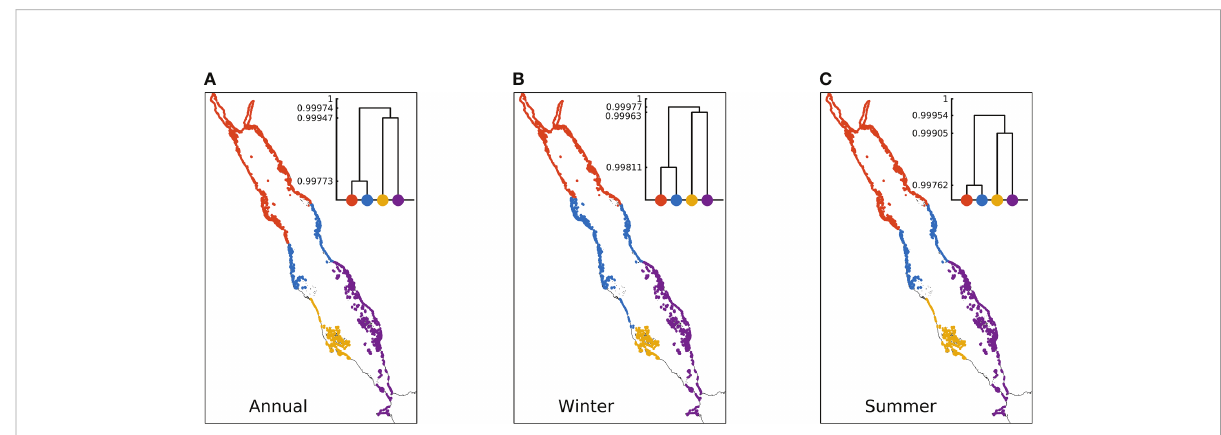
FIGURE 7 Clustering results for Red Sea coral reefs based on the connectivity matrix of simulations conducted during (A) the entire year, (B) winter and (C) summer. Each cluster is marked with a single colour. The representative clustering number K = 4 is selected as the cut-off threshold to depict the general basin-scale patterns. The dendrograms demonstrate the hierarchical clustering: the height of each U-shaped line that connects the data points indicates the dissimilarity between the two clusters, with a higher line indicating a less connected